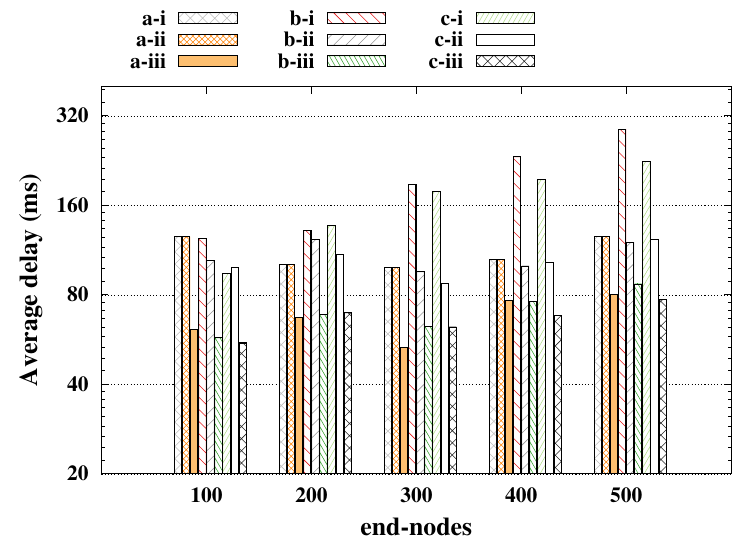
Figure 4. Alarm nodes’ delay for indoor industrial